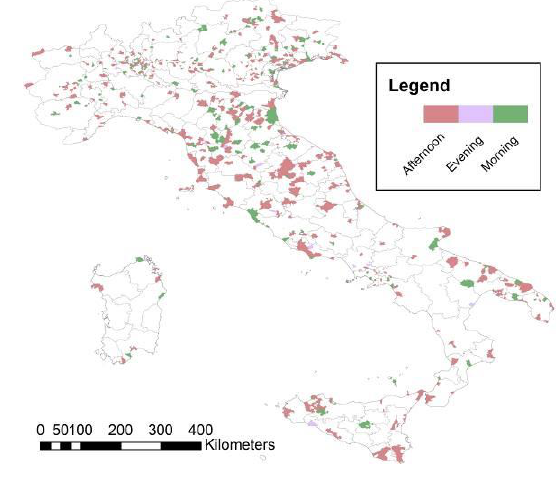
Figure 6. Activity rate in different commutes heightens at different time intervals.